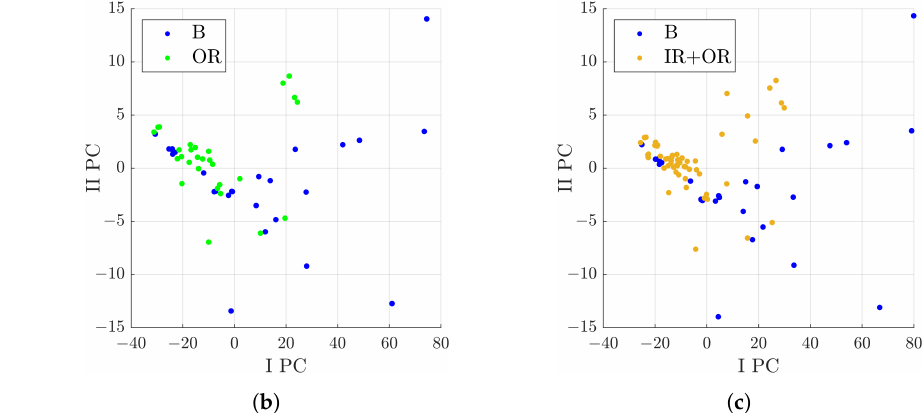
Figure 17. Distribution in the I PC–II PC plane of the analysed signals with respect to the charac- teristics selected by the Pareto method out of 11 after denoising with Group 49: ( a ) comparison between B and IR classes; ( b ) comparison between B and OR classes; ( c ) comparison between B and IR+OR